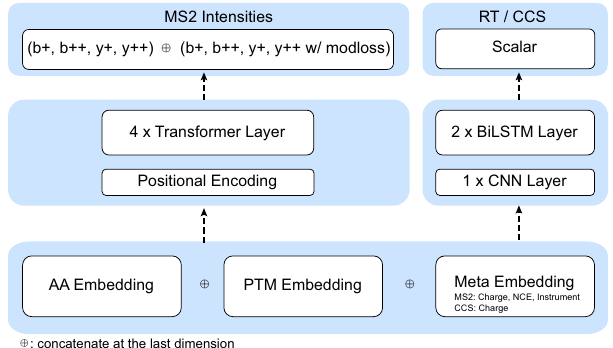
Fig. 2 | The built-in and pre-trained MS2, RT, and CCS prediction models. The MS2modelis built on four transformerlayers, and the RT/CCS modelsconsist of a convolutionalneuralnetwork(CNN)layerfollowedbytwobidirectionallongshort- term memory (BiLSTM) layers. The pre-trained MS2 model currently supports predicting the intensities of backbone b/y ions as well as their modi fi cation- associated neutral losses if any (e.g. – 98Da loss of phosphorylation on Ser/Thr). However, the user can easily con fi gure the MS2 model to train and predict water and ammonium losses from backbone fragments as well. RT retention time, CCS collision cross section, MS2 intensities of fragment spectra, BiLSTM bidirectional long short-term memory, CNN convolutional neural network, AA amino acid, PTM post-translational modi fi cation, NCE normalized collision